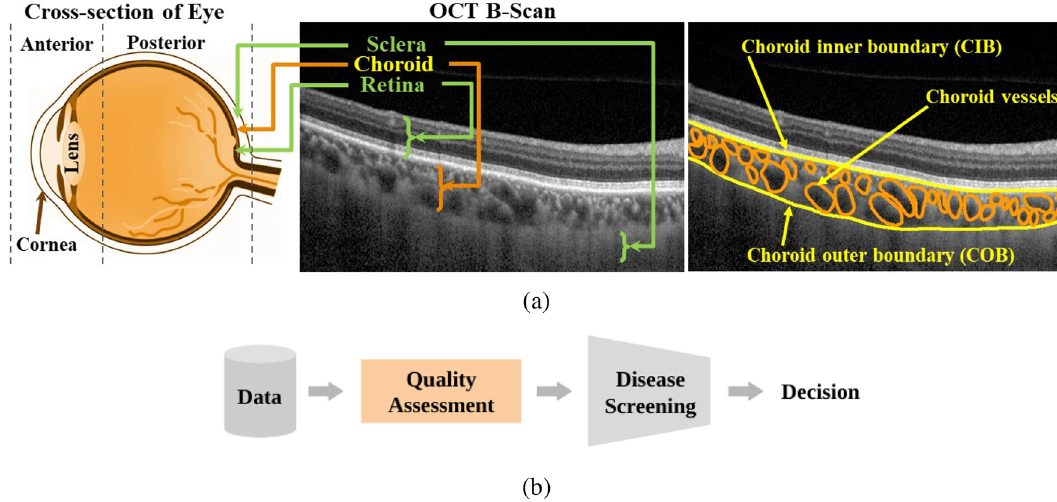
Figure 1. ( a ) Sagittal cross-section of the eyes ( Left ); Sample OCT cross-sectional image (B-scan) depicting posterior segment layers including retina, choroid, and sclera ( Middle ); and OCT B-scan depicting choroidal boundaries and vessels ( Right ), and ( b ) Desired disease screening pipeline with quality assessment as an essential